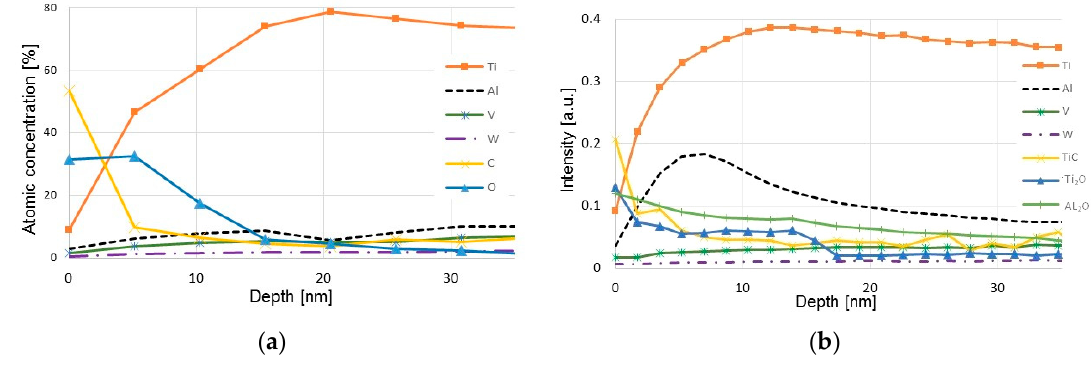
Figure 15. ( a ) AES and ( b ) time of flight secondary ion mass spectroscopy (ToF-SIMS) depth profiles of the backside—i.e., the surface in contact with the rake face—of a Ti-6Al-4V chip.